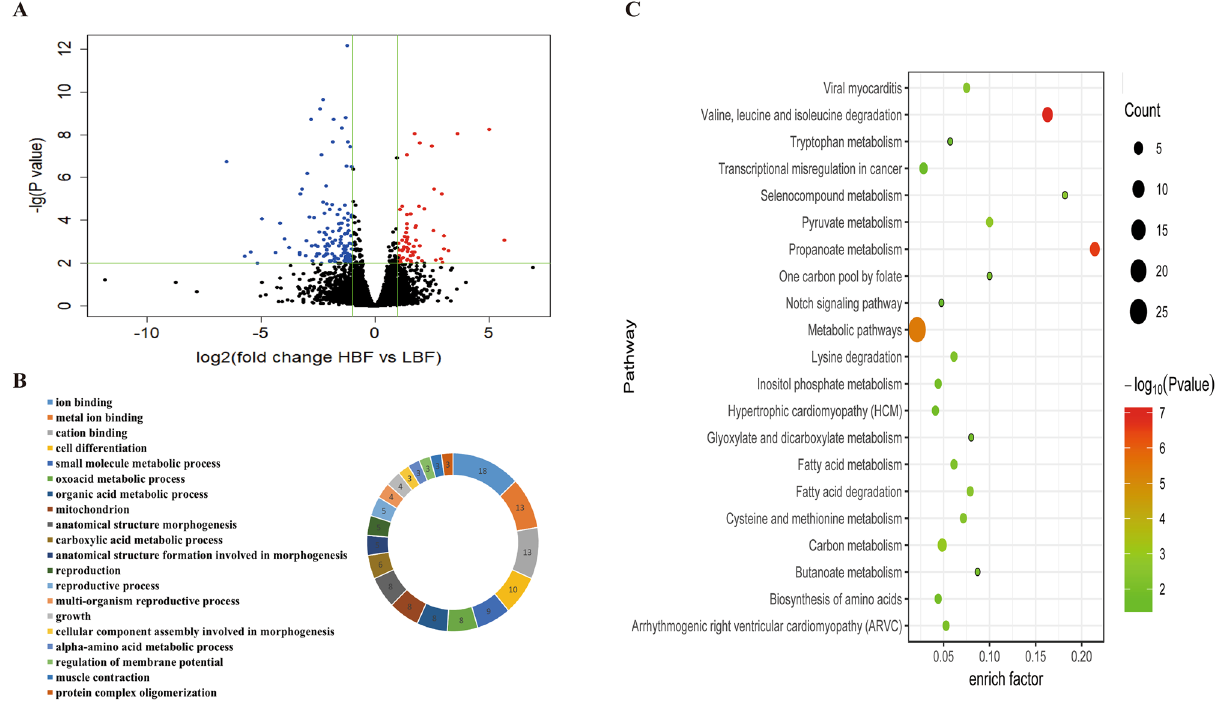
Figure 2. Identification and functional analysis of DEGs in the HBF and LBF groups. ( A ) Volcano plot of DEGs from samples of subcutaneous fat. The abscissa indicates log 2 FC, the ordinate indicates -lg(FDR) values, red dots indicate differential expression of upregulated genes, blue dots indicate differential expression of downregulated genes, and black dots indicate no differential expression. ( B ) GO enrichment analysis of DEGs between the HBF and LBF groups. ( C ) KEGG enrichment analysis of DEGs. The rich factor is the ratio of DEGs numbers annotated in this pathway term to the total gene numbers annotated in the same pathway term. Smaller P -values indicate higher